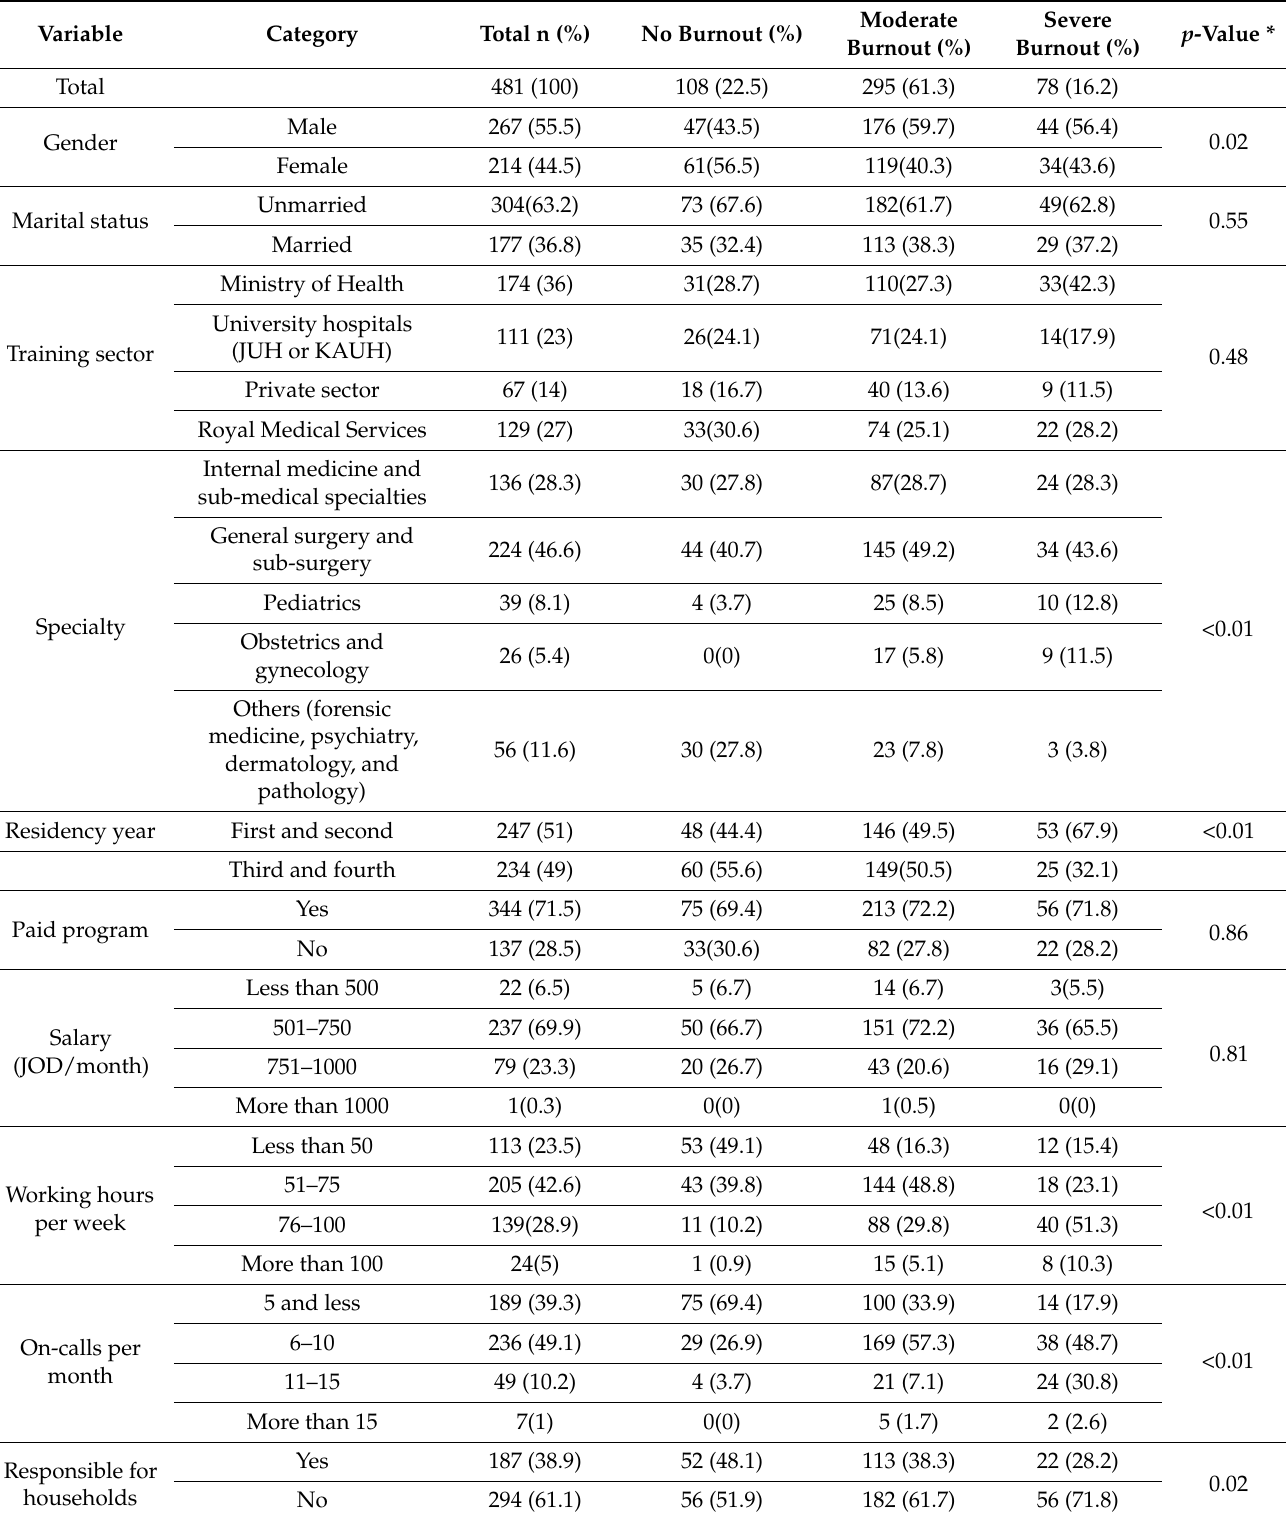
Table 1. Sociodemographic characteristics of 502 residents according to the levels of burnout as assessed by the Copenhagen Burnout